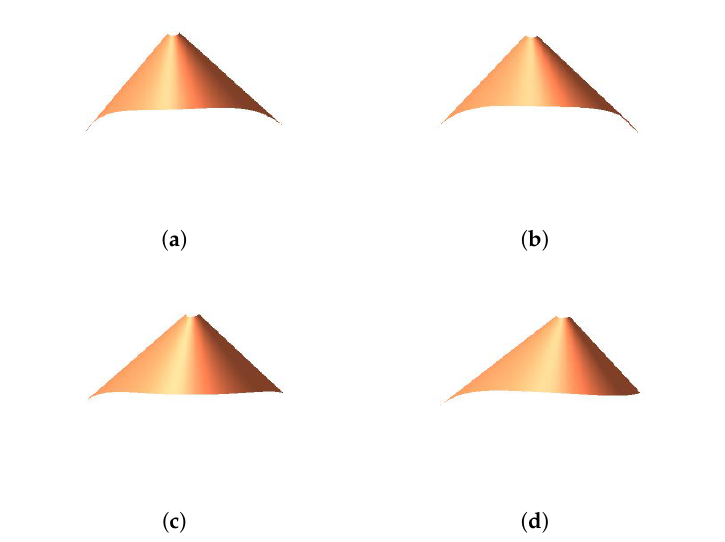
Figure 4. The effects of parameter α 1 on the 1 × 3 developable surface. ( a ) α 1 = π